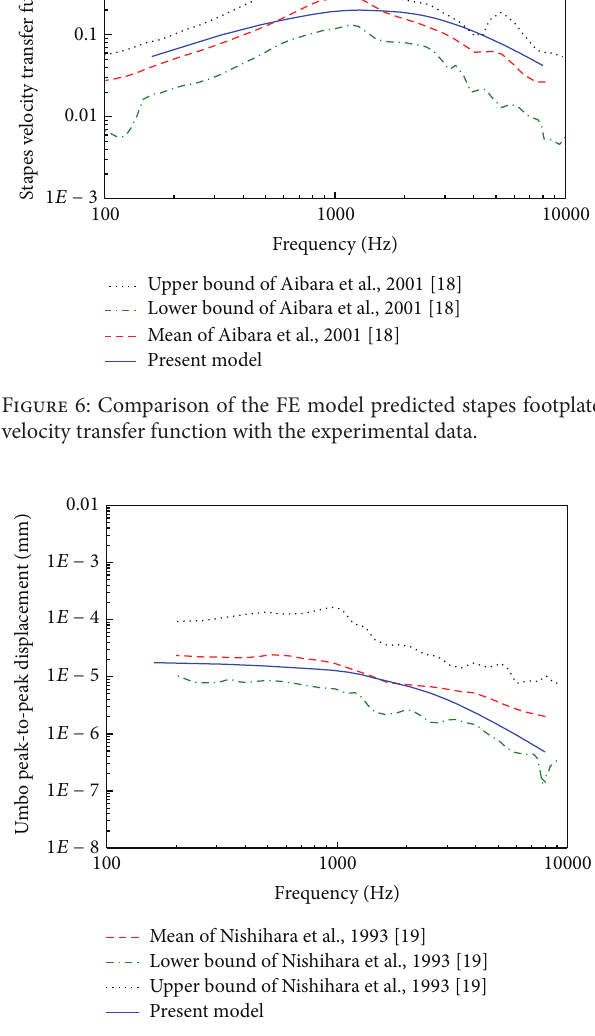
Figure 7: Comparison of the FE model predicted umbo displace- ment with the experimental